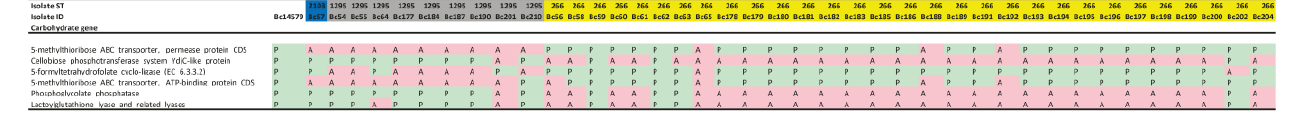
Figure 4. The presence/absence of genes related to carbohydrate utilization shows the closest agree- ment to ST found in all the strains showing differences in gene composition. P = presence of a gene; A = absence of a gene; Bc14579 is B. cereus ATCC 14579; ST57 is highlighted in light blue, ST1295 is highlighted in gray, ST266 is highlighted in yellow.